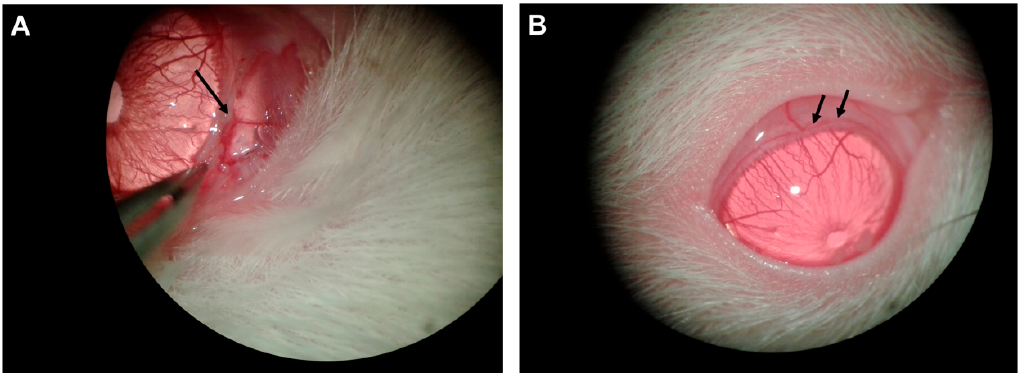
Figure 1. Induction of chronic intraocular pressure (IOP) elevation. ( A ) The limbal vascular plexus was exposed after carefully dissecting the conjunctiva. Then, a microneedle was positioned tangentially to the cornea and a volume of 50 µL polidocanol 3% was slowly injected into the perilimbal vessels. ( B ) Vessel blanching (arrows) and the extent to which the sclerosant went through the limbal vessels were carefully evaluated after injection.